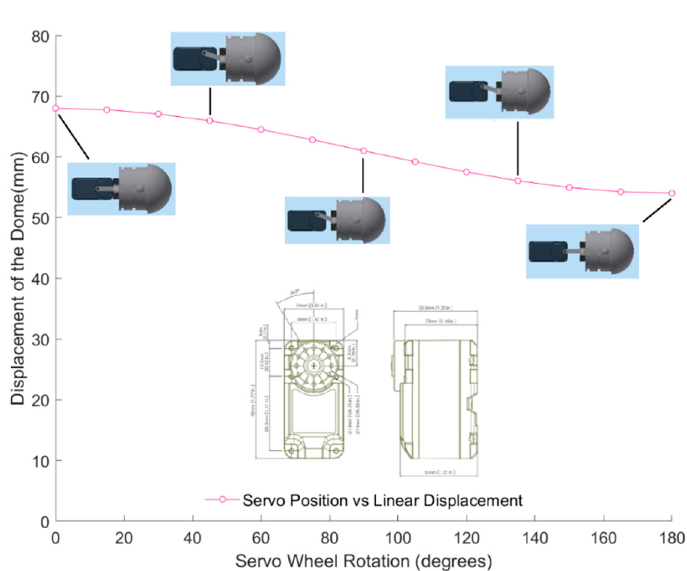
Figure 10. Displacement of the head dome—servo wheel rotated (in degrees).